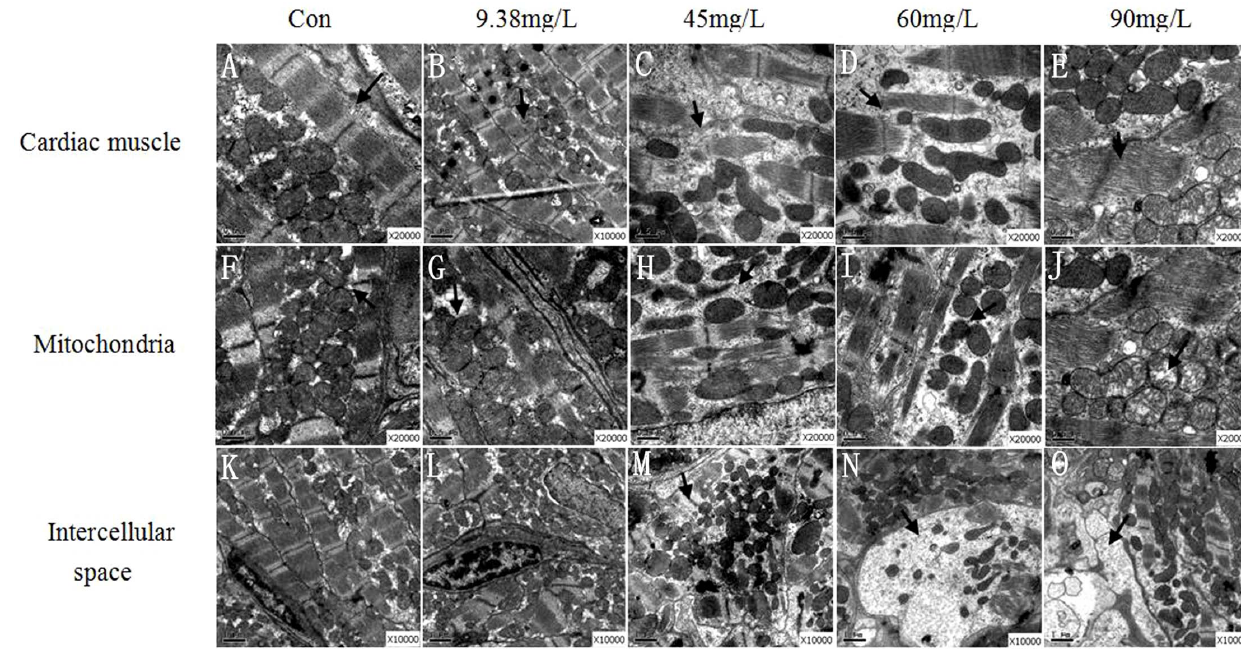
Figure 7. Histopathological analysis of heart tissue.